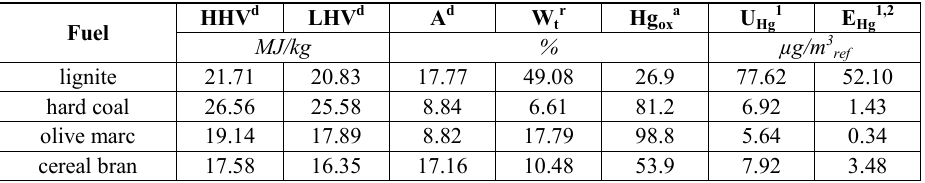
Table 2. Selected proximate properties of the solid fuels and calculated mercury concentrations in both raw and cleaned flue gases